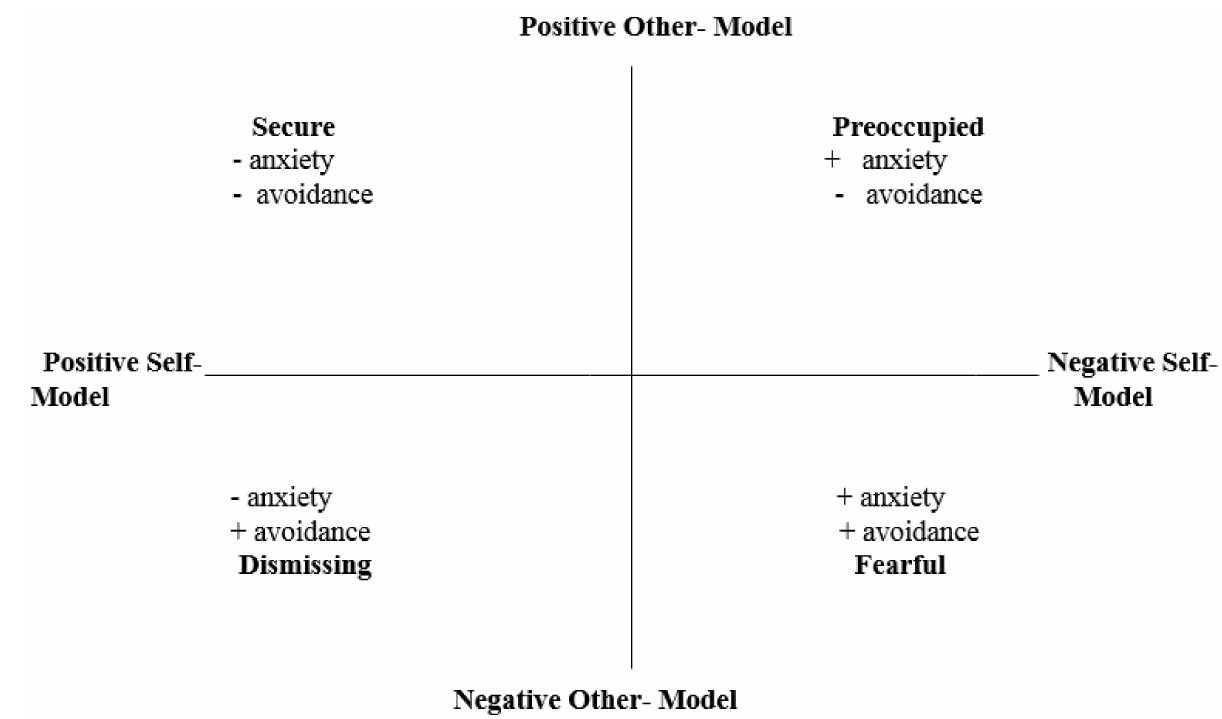
Figure 2. Four-Factor Model of Adult Attachment (Bartholomew & Griffin, 1994) with Two-Dimensional Model of Attachment (Brennan, Clark, & Shaver, 1998)